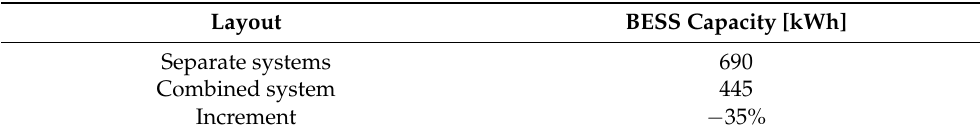
Figure 20. Abatement Ratio vs. Battery Capacity: ( a ) wavelet power smoothing vs. conventional approaches ( b ) AR achieved with the wavelet power smoothing method using separate vs. combined ESSs. Table 8. Comparison between separate vs. combined configuration (AR = 90%). Wavelet-based battery management.